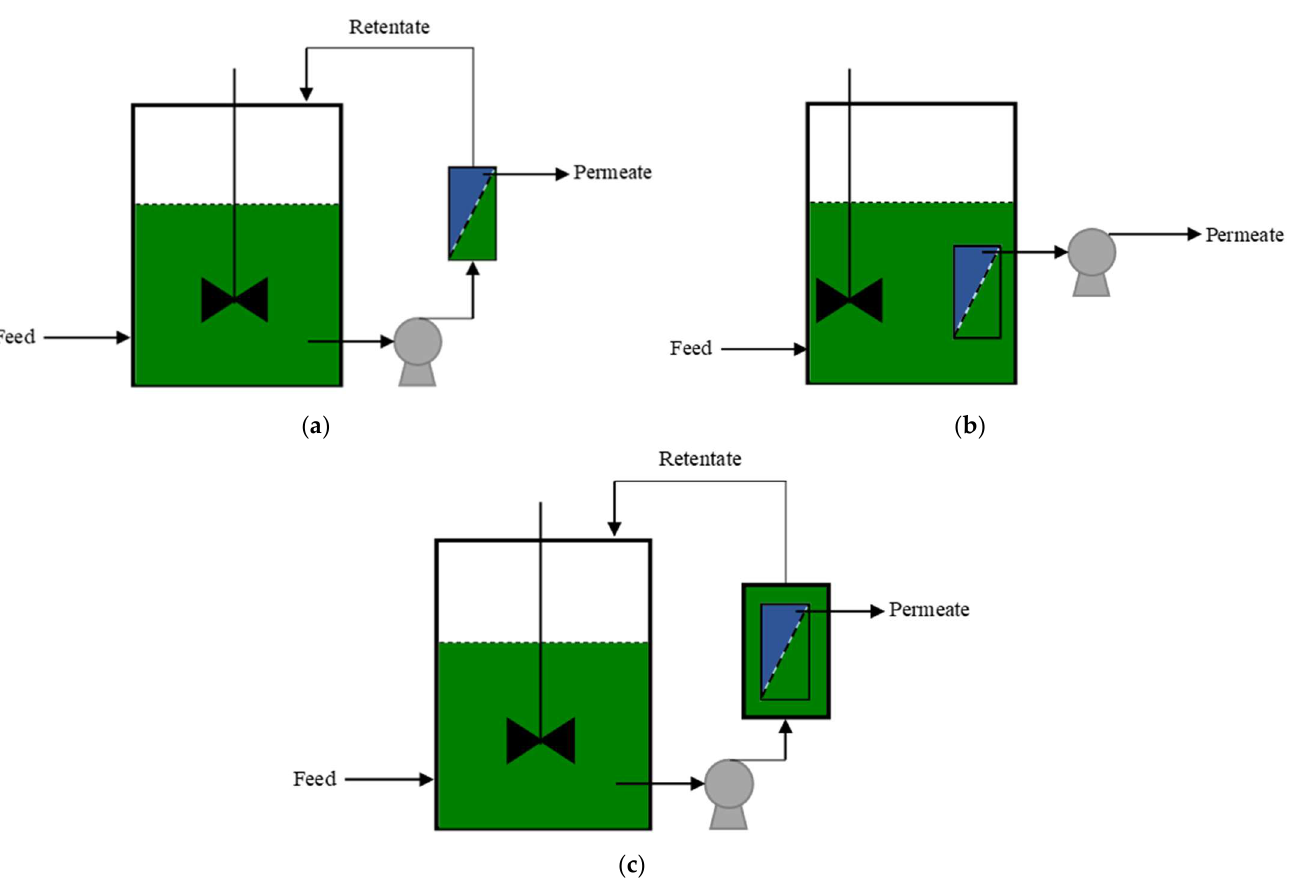
Figure 2. The configurations of AnMBRs: ( a ) External; ( b ) Submerged; ( c ) External submerged. Adapted from [45,61,64,72,118,119].